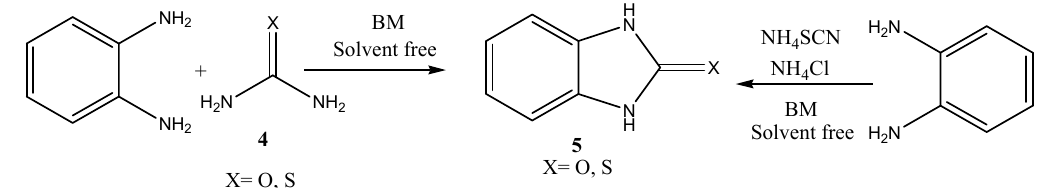
Scheme 2. Synthesis of benzimidazol-2-one and benzimidazol-2-thione.